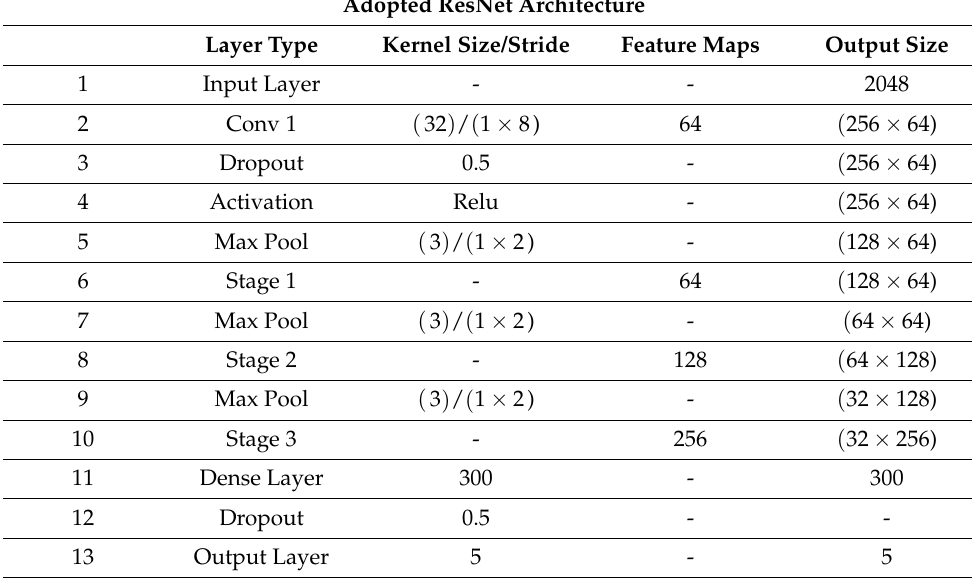
Table 6. Architecture of